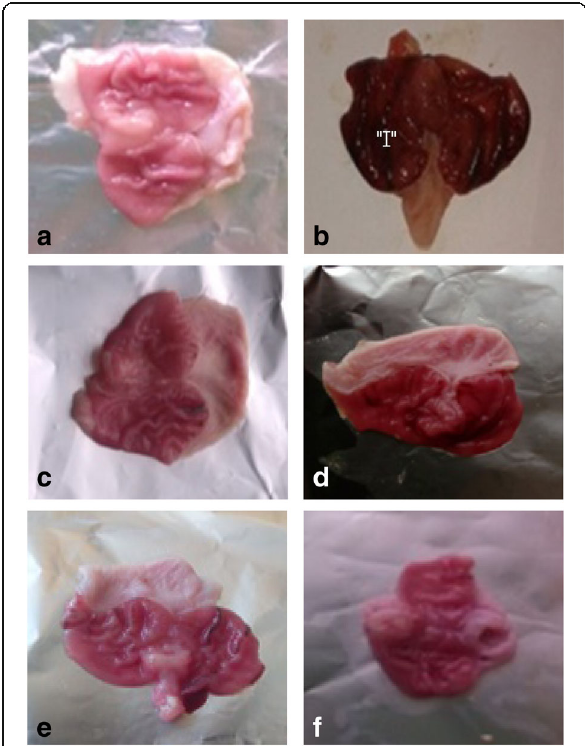
Fig. 3 Gross appearance of the gastric mucosa. a Normal control: no mucosal damage was observed , b Ethanol control: marked ulcers along with hemorrhagic streaks and mucosal damage were observed, c 20 mg/kg omeprazole, mild injuries were observed in the gastric mucosa as compared to the ethanol control group, d 100 mg/kg methanolic extract of P. Niruri : moderately reduced gastric mucosal damage and ulcers were observed, e 200 mg/kg ethanolic extract of P. Niruri : significantly reduced gastric mucosal damage and ulcers were observed, f 400 mg/kg methanolic extract of P. Niruri : no damage to the gastric mucosa was observed and gastric mucosa appeared flat as compared to the ethanol control. “ I ” indicates gastric mucosal damage and hemorrhagic streaks